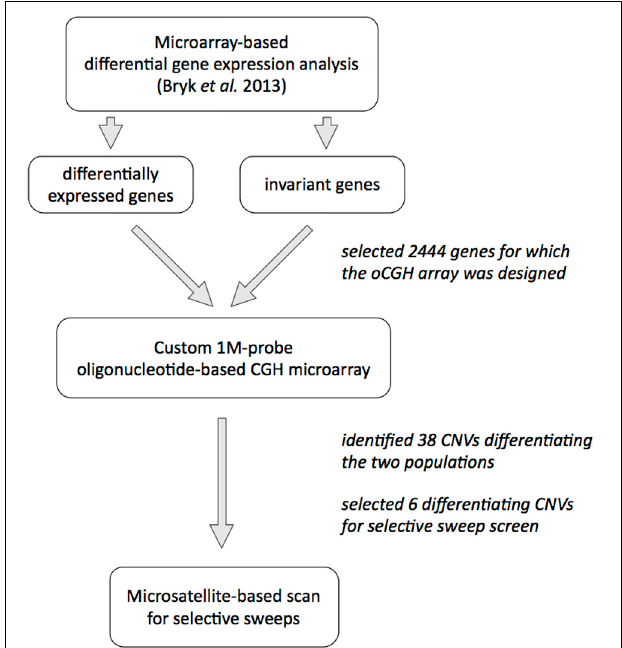
FIGURE 1 | Overview of the experimental